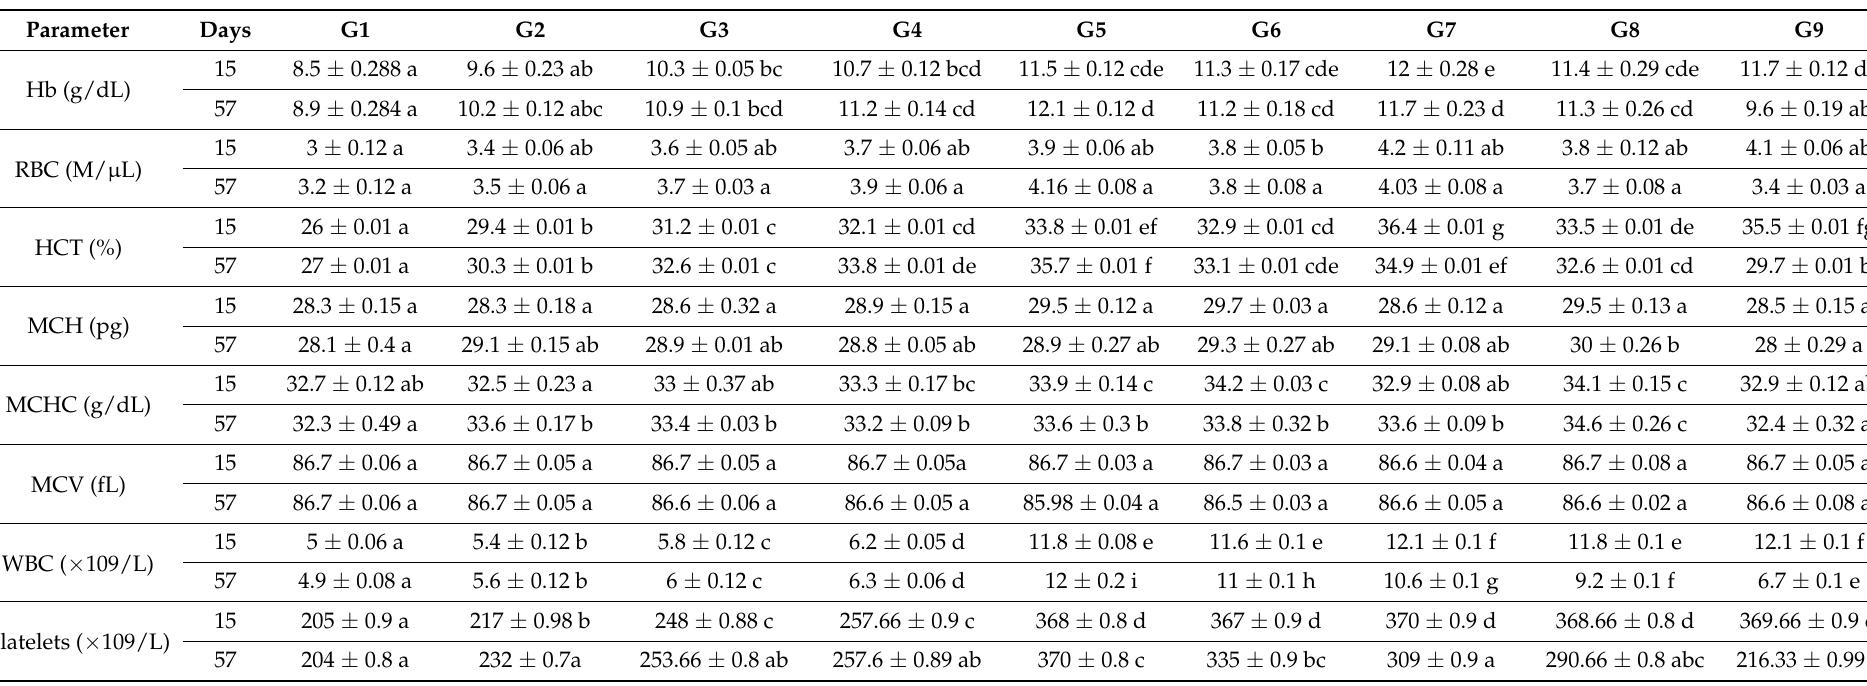
Table 1. The influence of L. plantarum , L. casei , S. platensis and in their combination on complete blood count of albino mice at 15 and 57